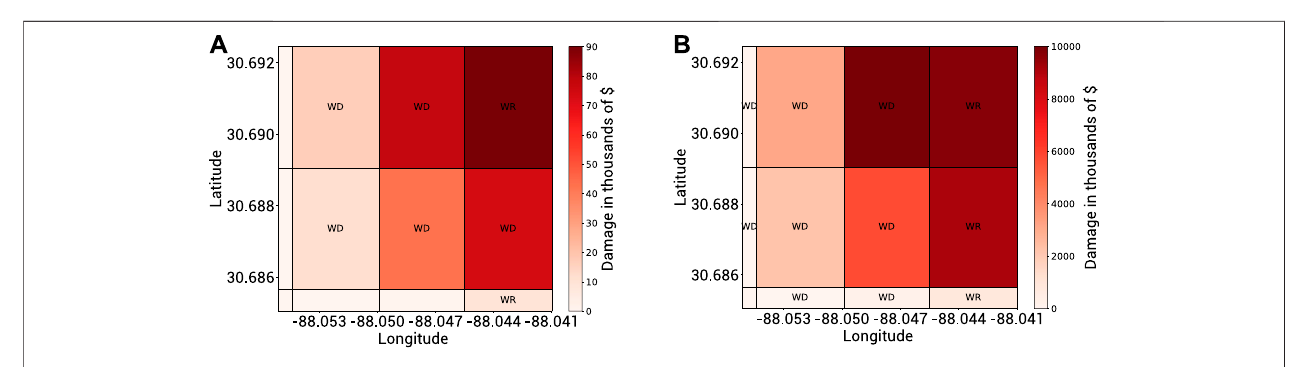
FIGURE 16 | Expected losses for scenarios (A) S KN2100-4.5 and (B) S KS2100-4.5.